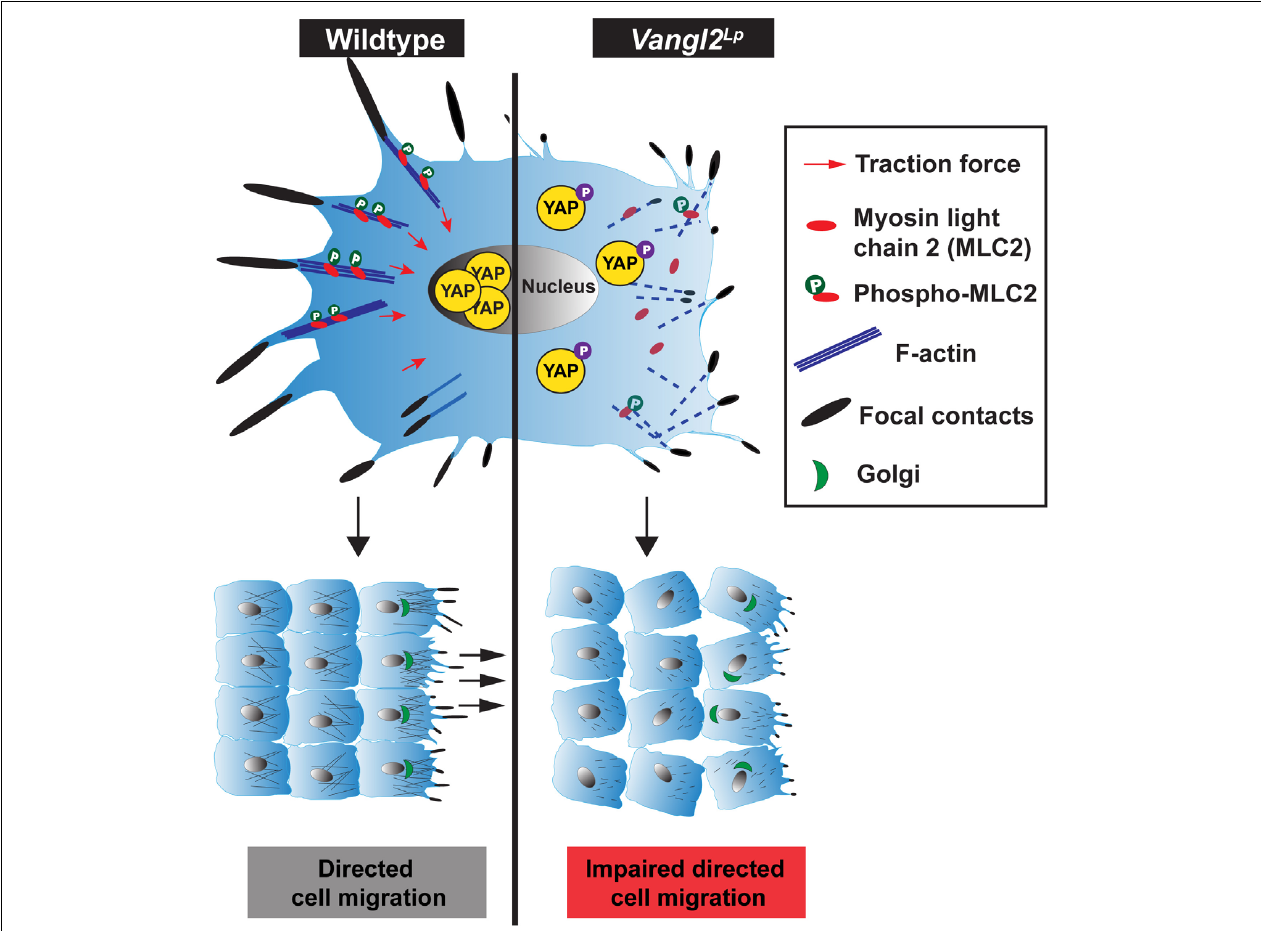
FIGURE 7 | Comparison of cellular mechanics in wildtype and Vangl2 Lp cells. (Left) In a normal cell, VANGL2 regulates the activation of myosin light chain 2 (MLC2) and F-actin and induces intracellular contractility. This gives rise to the generation of cellular traction force (red arrows) and promotes the formation of focal adhesion complexes. High mechanical cues within a cell then activate YAP signaling, rendering the translocation of YAP to the nucleus, leading to the transcriptional induction of YAP target genes. The optimal coordination of focal complexes, actomyosin contractile activity at the rear and pushing force at the front, as well as VANGL2-regulated cell polarity enables directed cell migration. (Right) In a Vangl2 Lp cell, VANGL2 dysfunction leads to highly disrupted actin cytoskeleton, aberrant focal complex formation, and inhibition of MLC2 activation. This causes defective actomyosin-mediated contractility, which hampers traction force generation. Attenuated mechanosignaling within the cell inhibits activation of mechanosensitive protein YAP. YAP is phosphorylated, rendering its sequestration in the cytoplasm, thereby causing the transcriptional suppression of YAP target genes. Perturbation of traction force generation, aberrant focal contact formation, the lack of pushing force caused by highly disrupted actin cytoskeleton, and defective VANGL2-regulated cell polarity impede directed cell